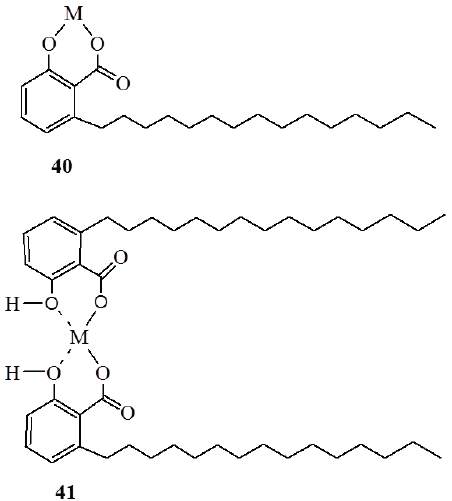
Figure 15. The metal complexes of anacardic acids 40 and 41